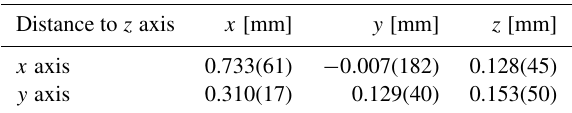
Table 5. Deviation of the position of the saddle points in x and y direction in respect to the z axis. Uncertainties are determined with a confidence level of 95% (last two